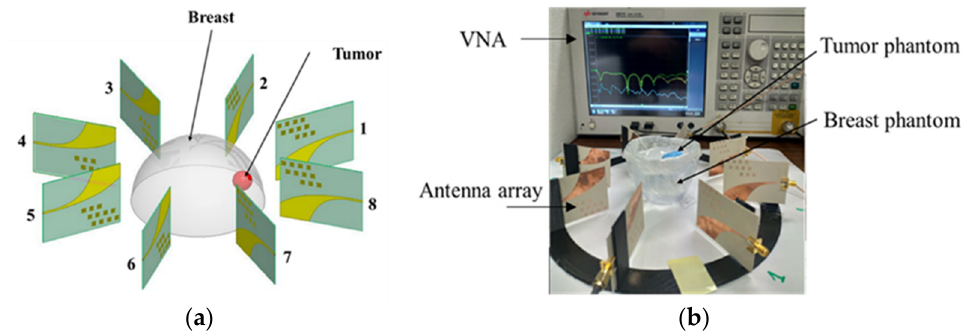
Figure 16. Array antenna for tumor detection: ( a ) conception design of the 8 antennas and the positioning from 1 to 8; ( b ) experimental system.